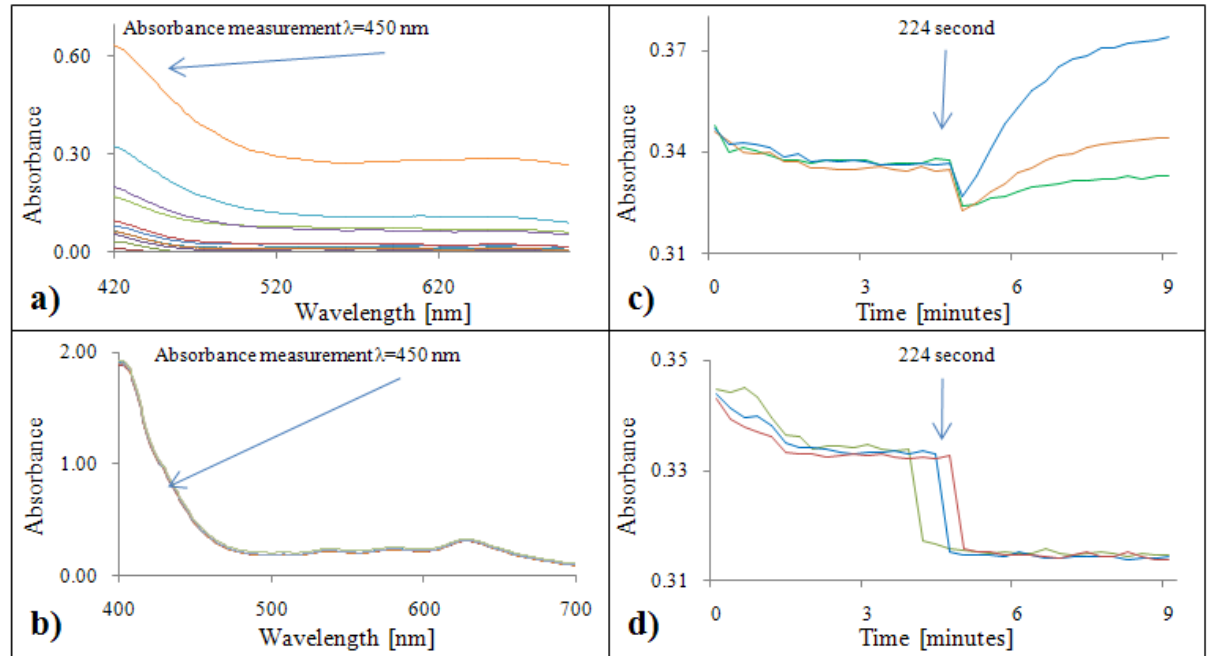
Figure 5. Free Radicals absoprtion spectra (450 – 700 nm) for gallic acid (a) and Trolox ® (b) . Dependence of absorbance of Free Radicals with gallic acid (c) and Trolox ® (d) on